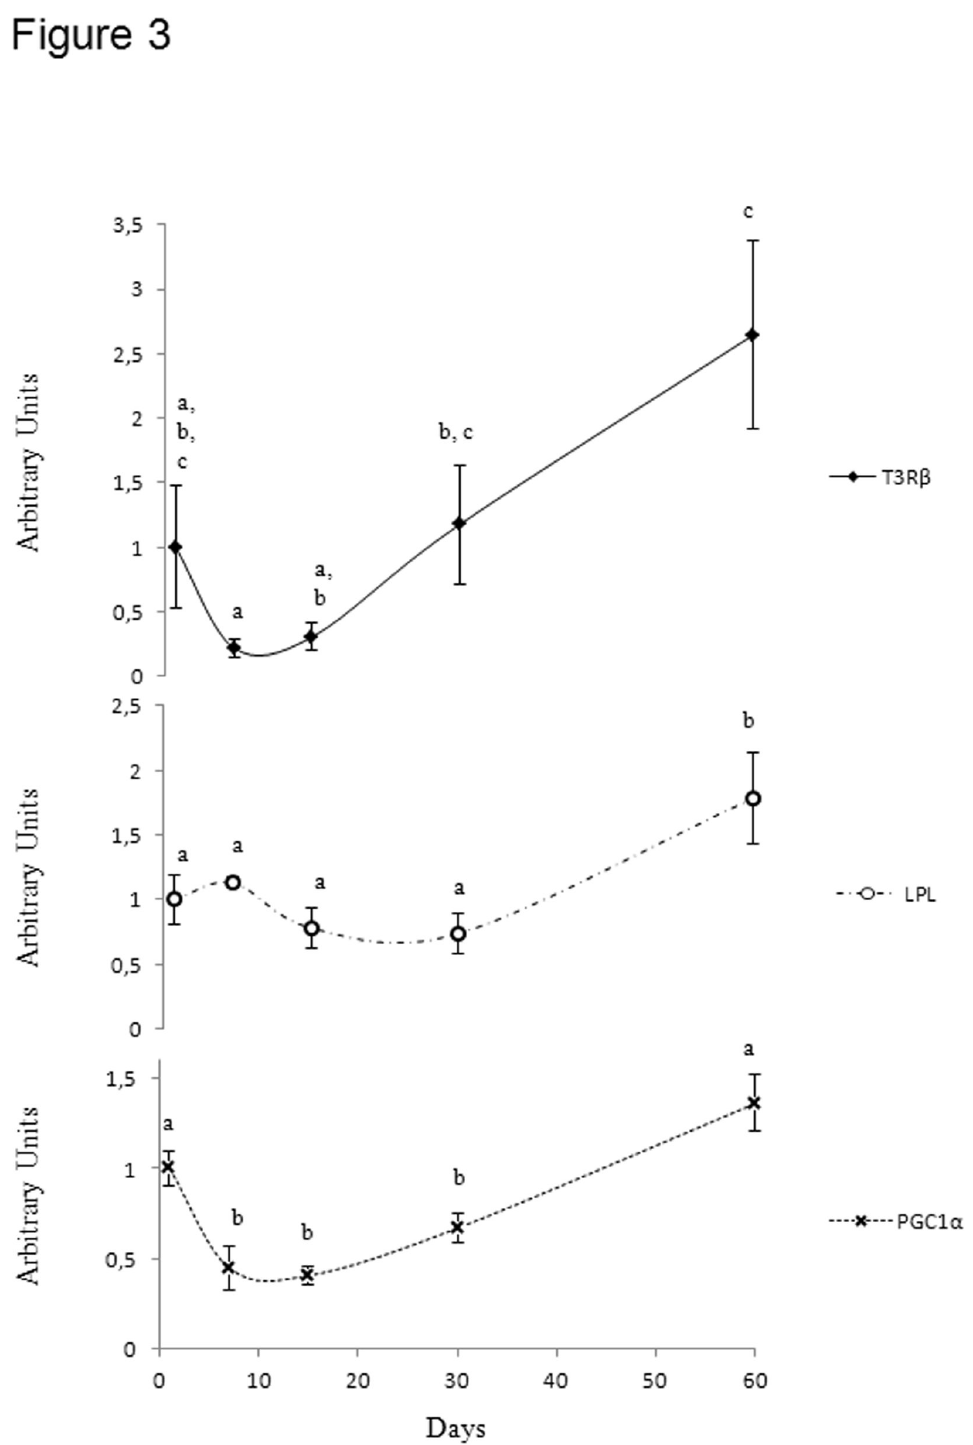
Figure 3. qPCR analysis of the expression of genes involved in transcriptional regulation and lipid metabolism. Time course of the levels of triiodothyronine receptor (T3Rβ), lipoprotein lipase (LPL), peroxisome proliferator-activated receptor-γ co- activator-1α (PGC-1α) transcripts in the pectoralis muscle of 1, 7, 15, 30 and 60-day- old Adélie chicks. The relative expression of each gene was expressed as a ratio to β-actin mRNA level. N = 6 per group. Bars correspond to means ± S.E.M. Bars with different letters are significantly different at p<0.05. doi: 10.1371/journal.pone.0074154.g003 PLOS ONE |